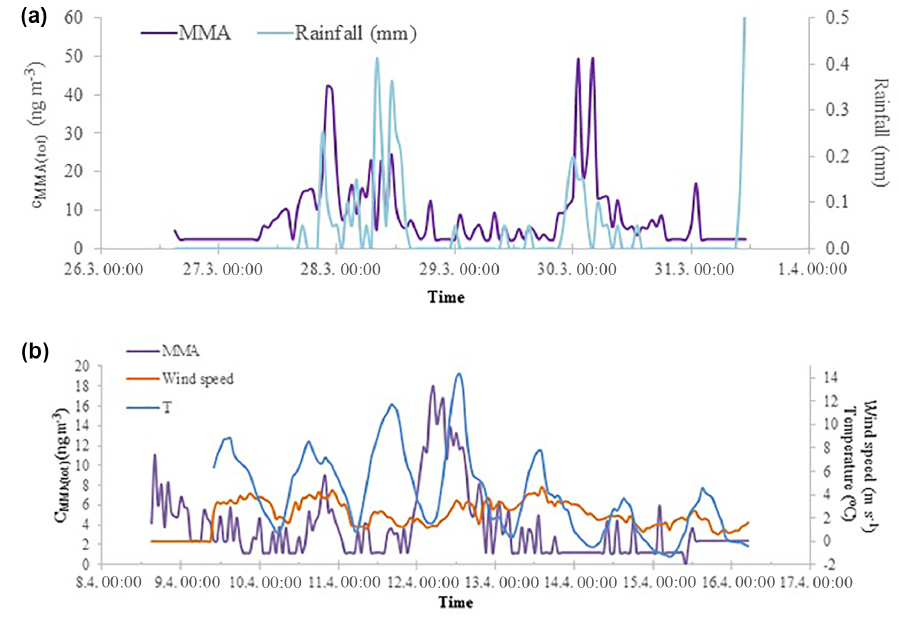
Figure 3. MMA(tot) concentrations and rainfall measured in Hyytiälä during spring 2015 in March (a) and MMA(tot) concentrations, wind speed, and ambient temperature in April (b) .